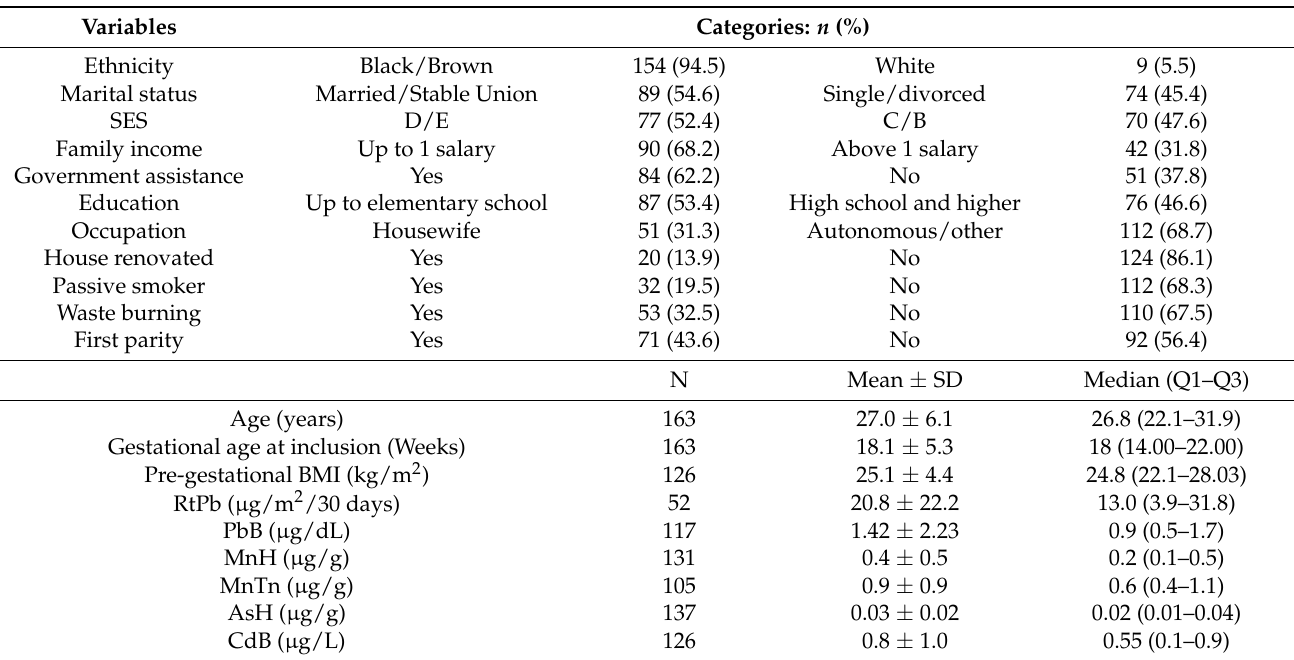
Table 1. Sociodemographic and descriptive characteristics of the evaluated biomarkers of the study